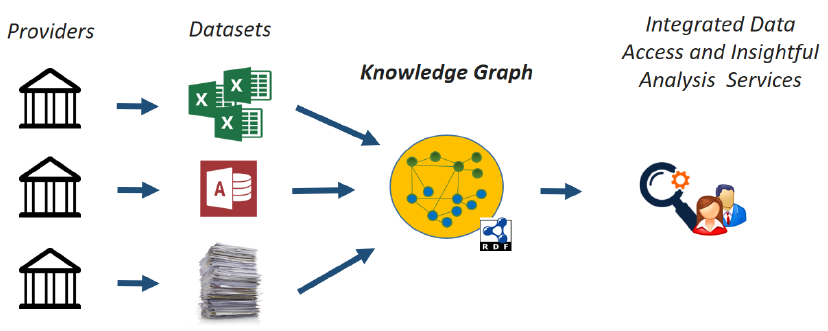
Figure 1. From Disparate and Fragmented Datasets to Knowledge